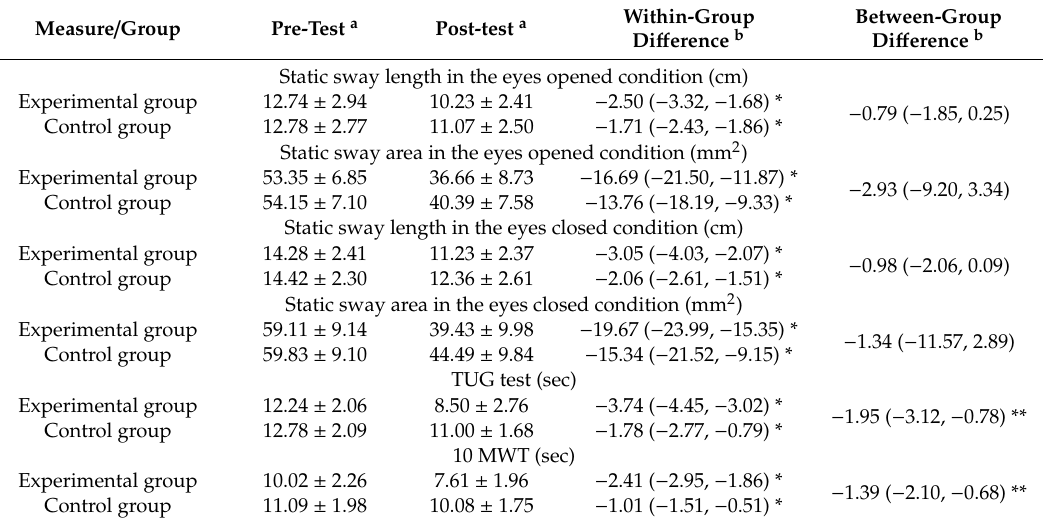
Table 3. Comparison of COP displacements, TUG, and 10-m walk test pre and